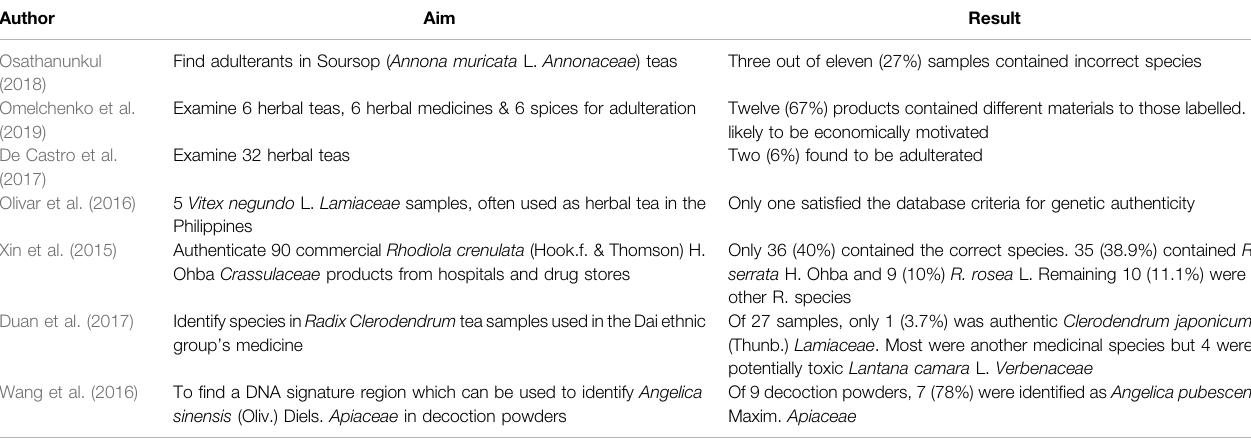
TABLE 5 | Results of genetic analysis on teas searching for